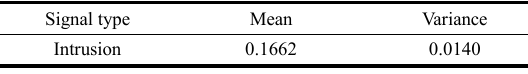
Table 1: Statistic on intrusion